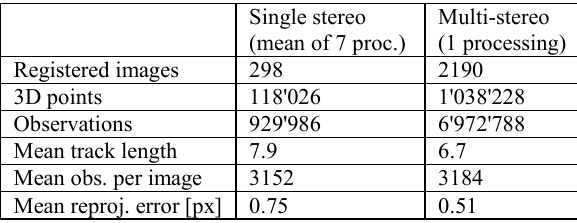
Table 1. COLMAP processing statistics for single stereo and multi-stereo image sequences